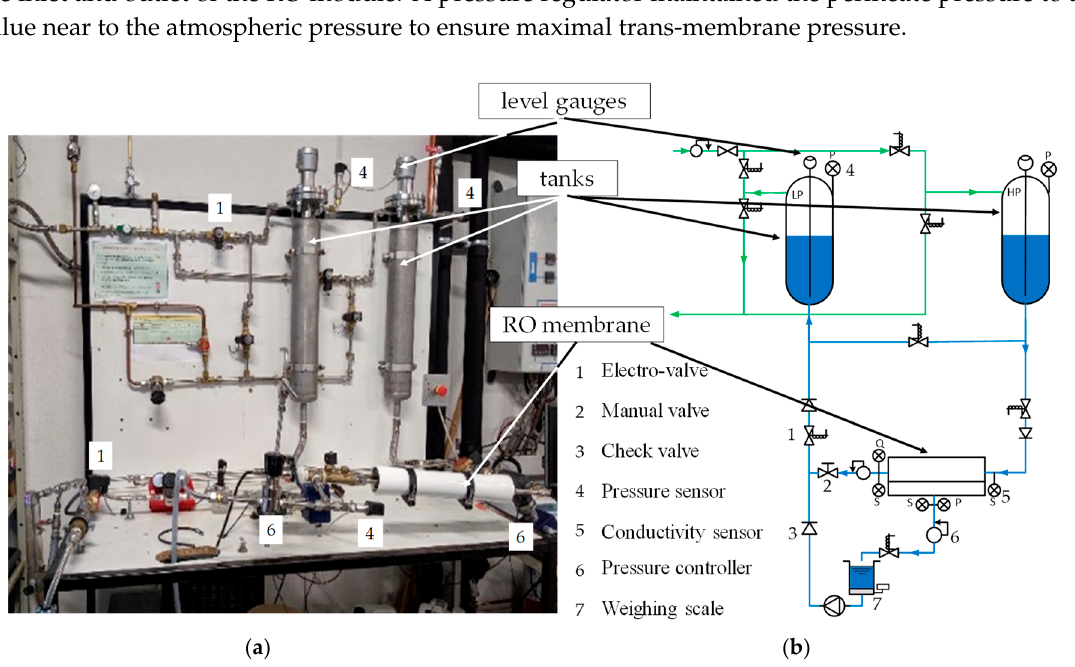
Figure 10. Picture ( a ) and schematic diagram ( b ) of the experimental setup.